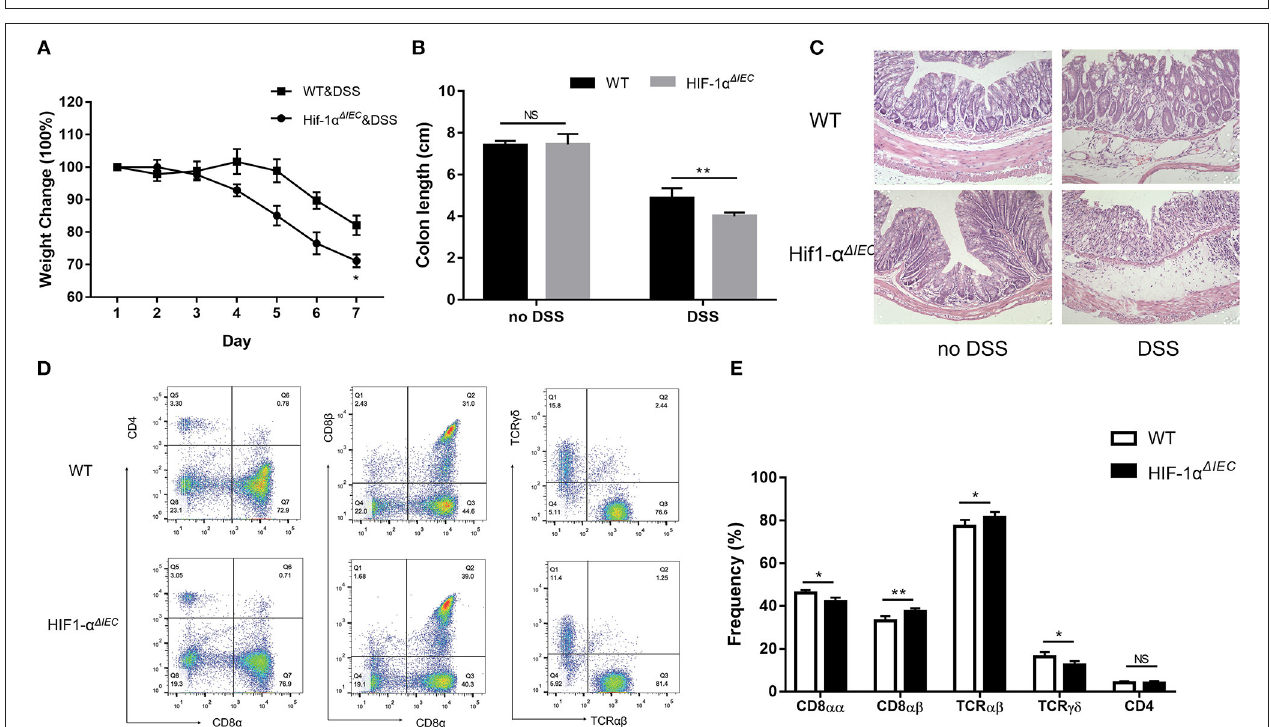
FIGURE 6 | Hif-1 α deficiency in epithelial aggravate colitis severity. Inflammation was assessed in DSS-treated WT and Hif1- α ∆ IEC mice by (A) weight loss, (B) colon length, (C) colon histological damage. (D,E) the proportionality of the indicated colon IEL subsets in DSS-induced colitis ( n = 5–7 mice/group). Images are 200x. * P < 0.05; ** P < 0.01; NS, not significant.